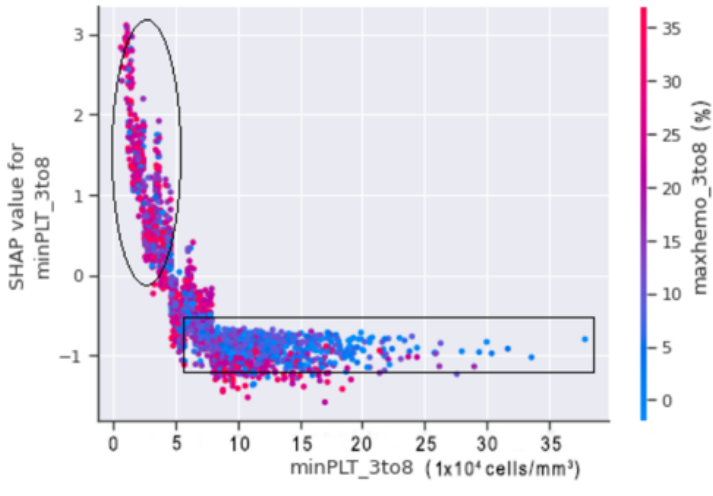
Figure 17. SHAP dependence plot between minPLT_3to8 and